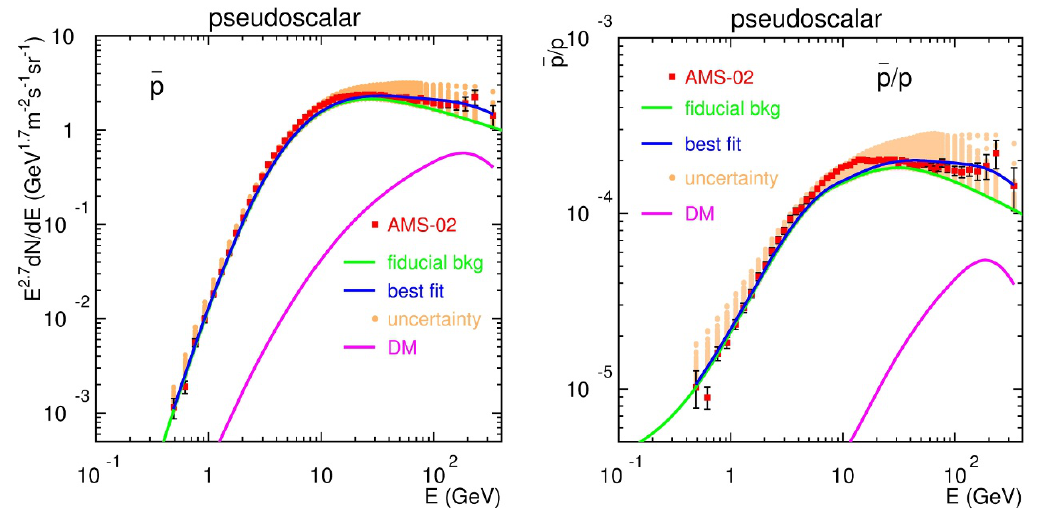
Figure 8 . Antiproton (cid:13)ux (left) and antiproton-to-proton ratio (right) in the pseudoscalar mediator model with only the antiproton (cid:13)ux data points included in the likelihood in eq.